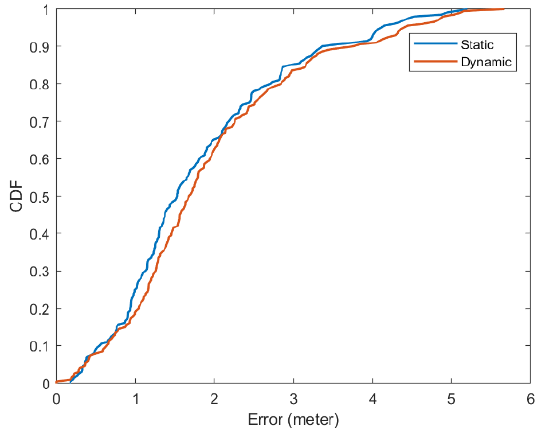
Figure 8. ( a ) Optimized KNN and data preprocessing, original KNN and data preprocessing. ( b )